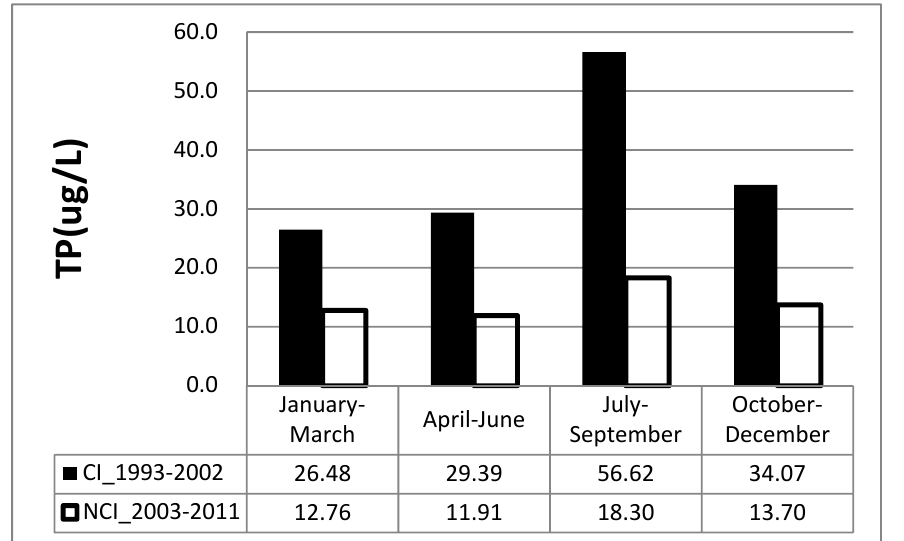
Figure 3. The average TP amount before and after seasonal influence